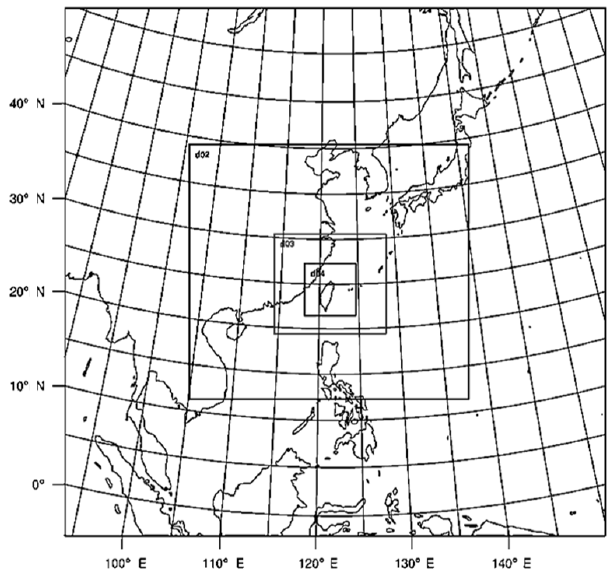
Figure 3. Map of the model domains for the simulations in this study. The resolutions are 81, 27, 9, and 3km in the outmost, 2nd, 3rd, and inmost domains,